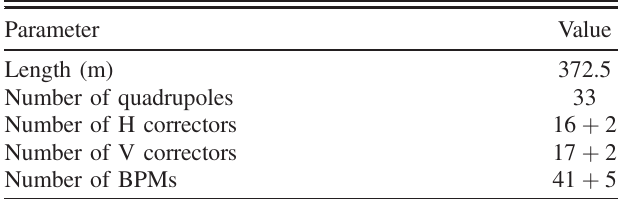
TABLE I. Elements of the LCLS-II copper soft x-ray LTU section used in simulation. Two correctors in each plane upstream of the section and five BPMs downstream of the section are added to the